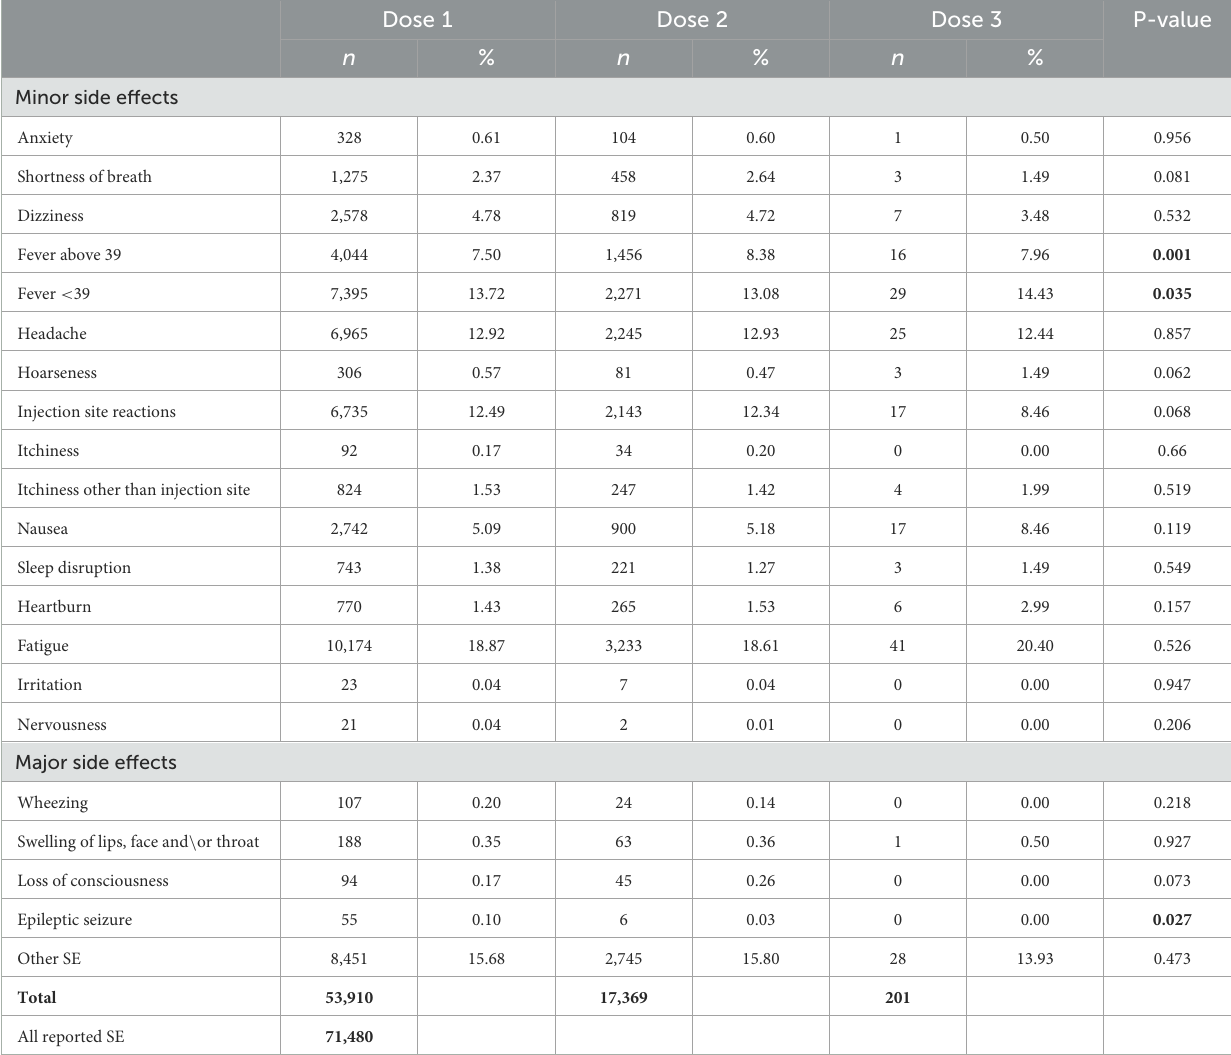
TABLE 3 Adverse events in relation to the number of vaccine doses received. Dose 1 Dose